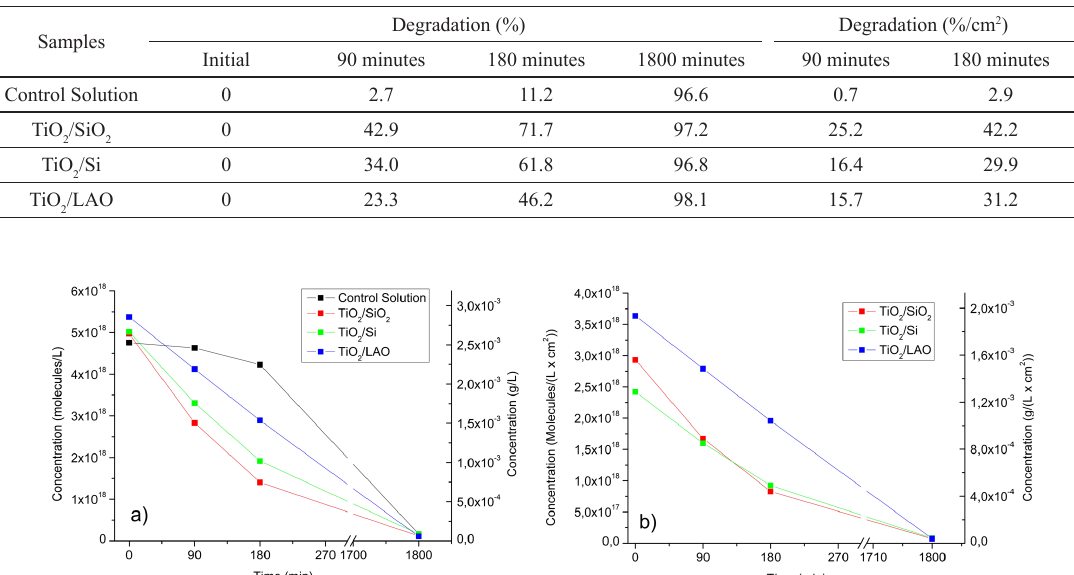
Table 2. Comparison of the degradation rate of the methylene blue solution in % and %/cm 2 for the reactor without photocatalyst (control solution) and for reactors containing TiO